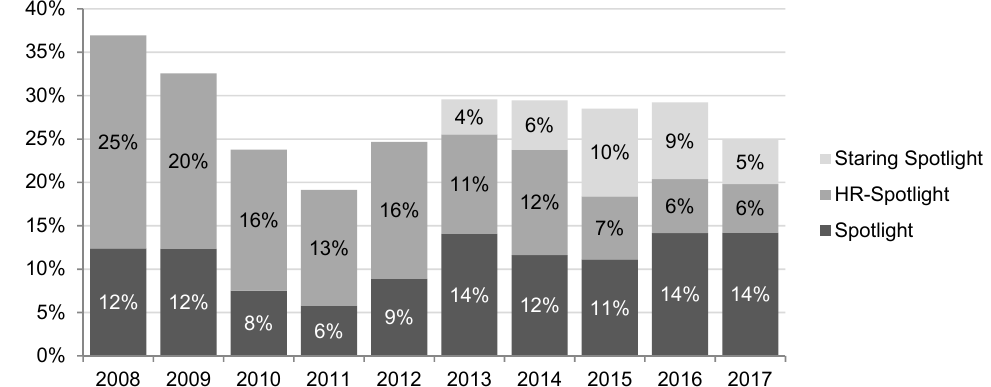
Figure 11. Proportion (in percent) of TerraSAR-X Spotlight modes on an annual basis from 1st January 2008 to 30th June 2017: The highest resolution Staring Spotlight mode displayed on top, the high-resolution HR-Spotlight mode in the middle and the standard resolution Spotlight mode at the bottom.